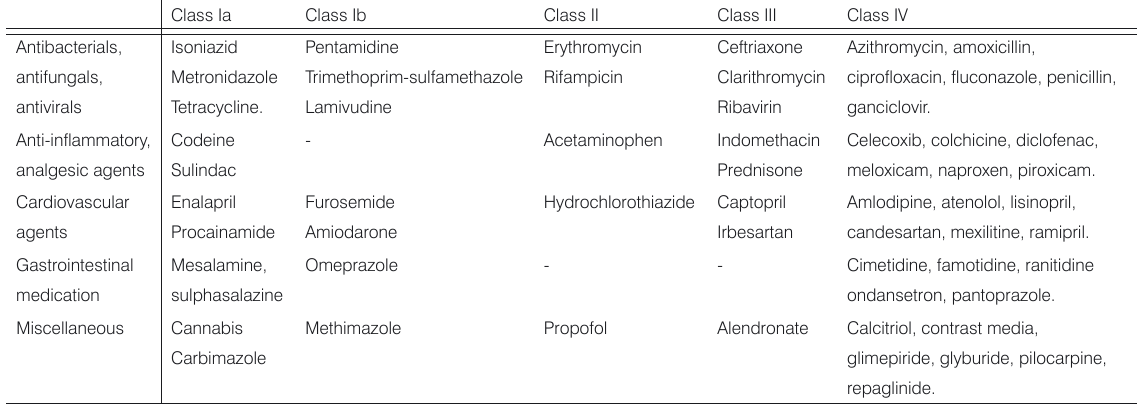
Table 1. Examples of drugs associated with pancreatitis [adapted from 2, 3, 4], Class Ia: at least 1 case report with positive rechallenge, excluding all other causes, or more than 20 cases of acute pancreatitis reported; Class Ib: at least 1 case report with positive rechallenge, other causes, and other drugs were not ruled out; Class II: at least 4 cases in the literature, consistent latency ( ≥ 75% of cases); Class III: at least 2 cases in the literature, no consistent latency among cases, no rechallenge; Class IV: single case report published in medical literature, without